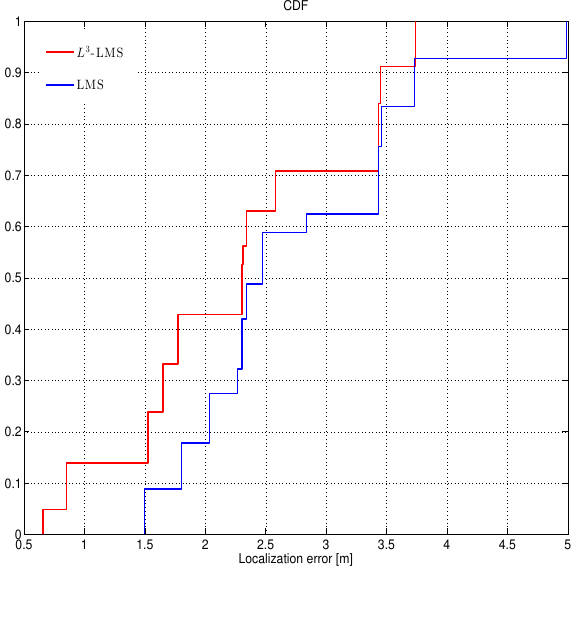
Figure 8. CDF of the localization error: actual performance of both the L 3 and least mean squares (LMS) algorithms, i.e. , with and without the use of predictive system,